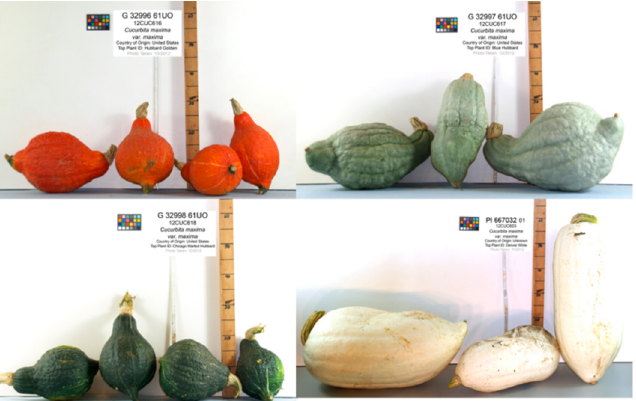
Figure 3. Mature fruits from different accessions of C. maxima Hubbard Cultivar ‐ group. Public do ‐ main photos, Germplasm Resources Information Network (GRIN), USA.